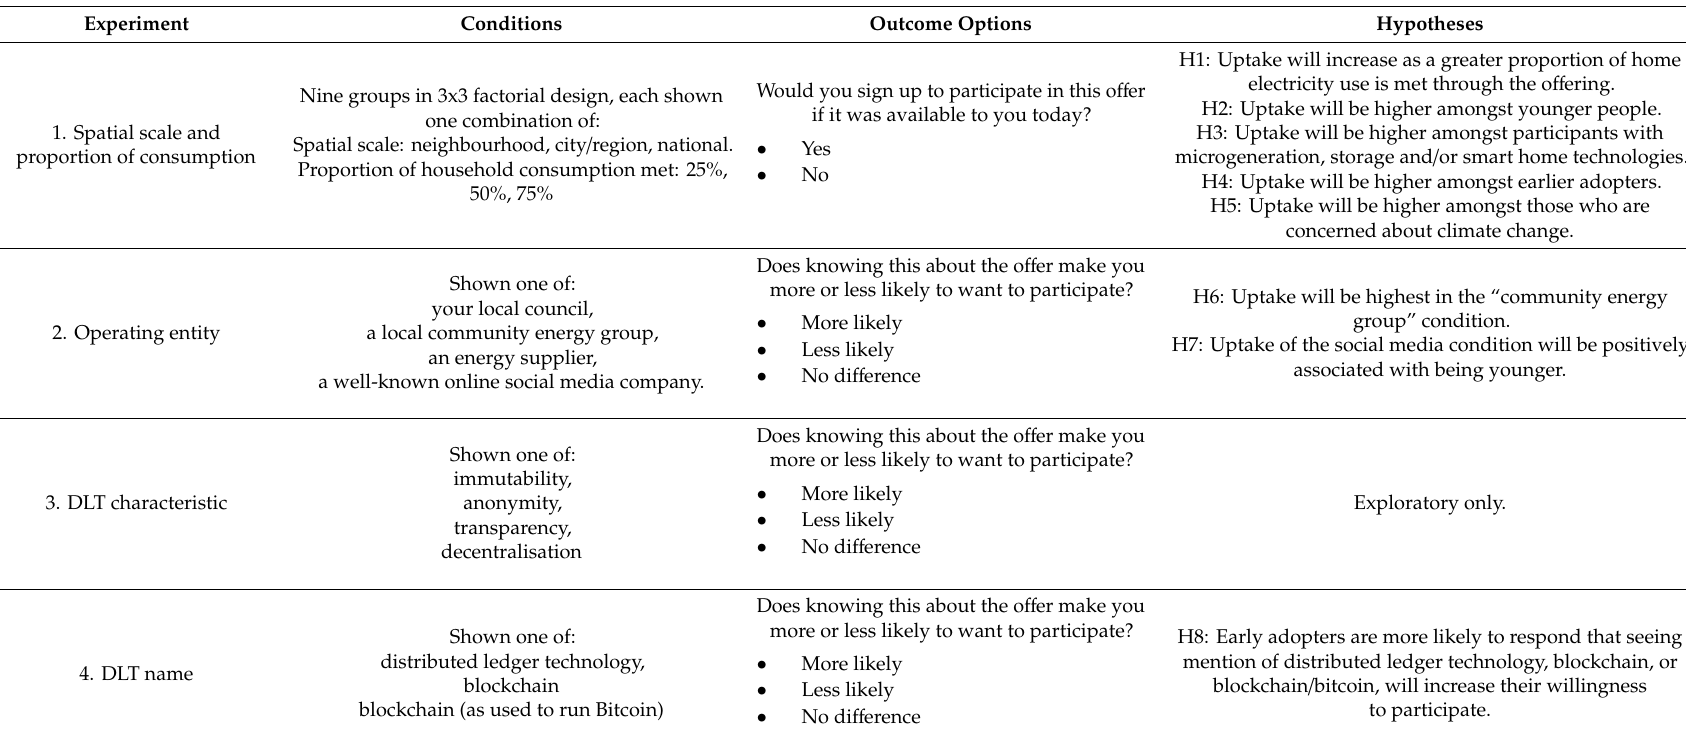
Table 1. Survey experiment overview and hypotheses.